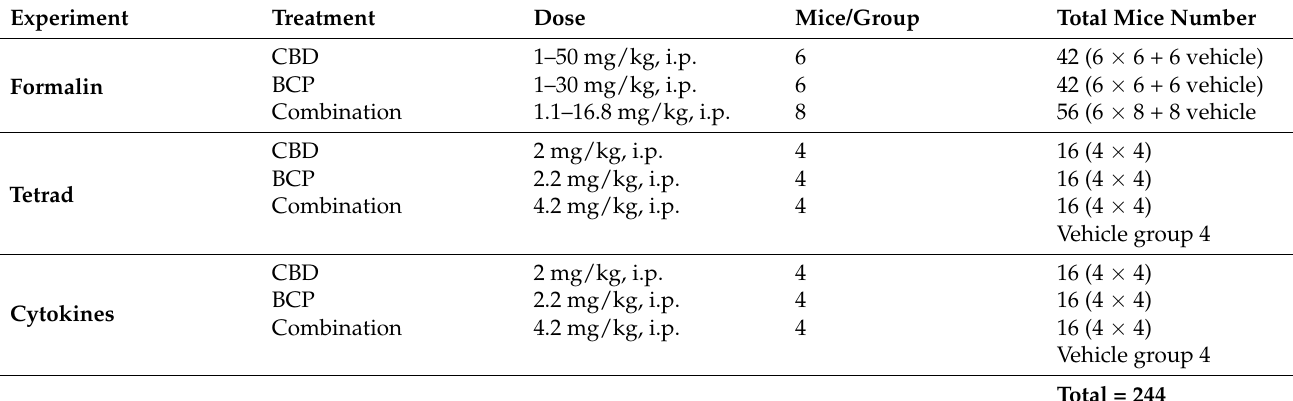
Table 1. Groups, treatment and